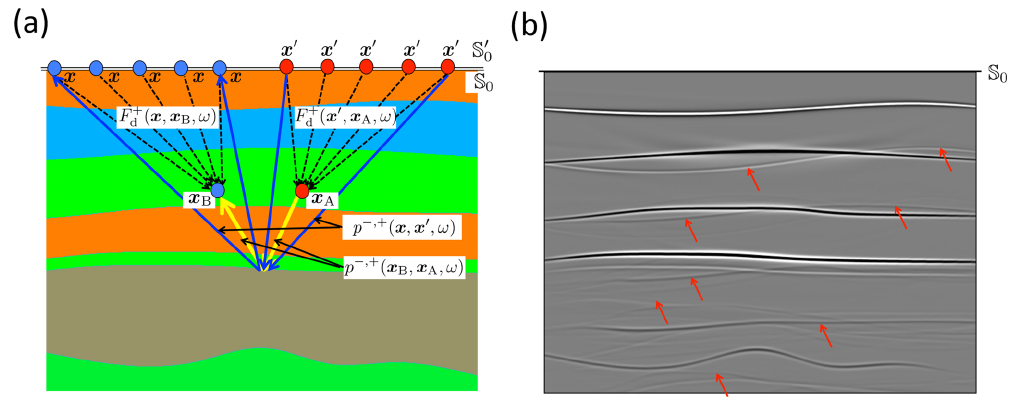
Figure 7. (a) Principle of source–receiver redatuming. (b) Reflectivity image r( x A ) ≈ p − , + ( x A , x A ,t = 0 ) for all x A . The red arrows indicate erroneously imaged